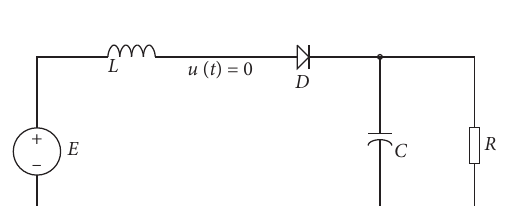
Figure 2: On mode.